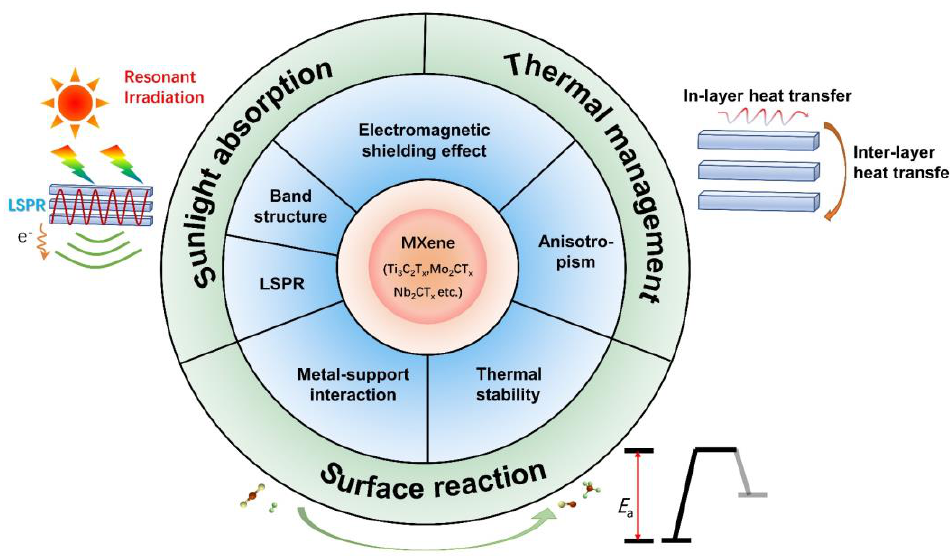
Figure 1. Properties and functionalities of MXene materials in fields of photothermal catalysis.